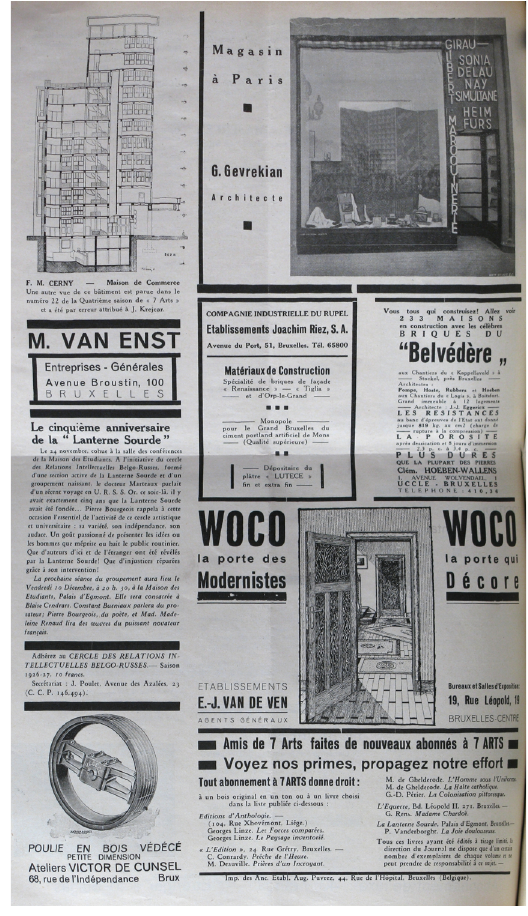
Fig. 18 7 Arts, 5th series, no. 1 (15 November 1926), 4, first occurrence of the